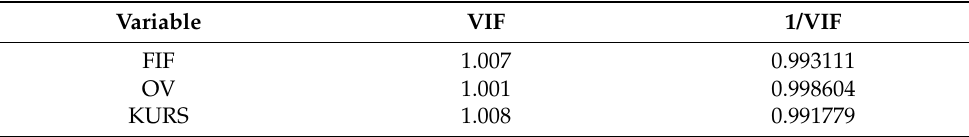
Table 17. Multicollinearity Test.